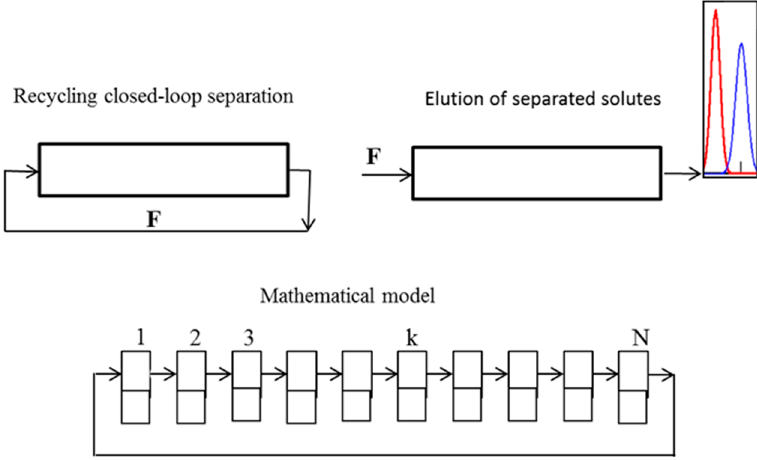
Figure 4. Scheme and principle of the ideal recycling mode of a CLR CCC separation and the applied mathematical model.